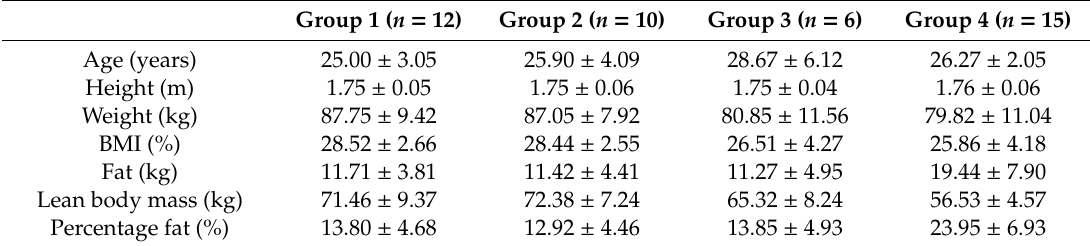
Table 2. Characteristics of the study subjects (nutrition analysis ver., Part